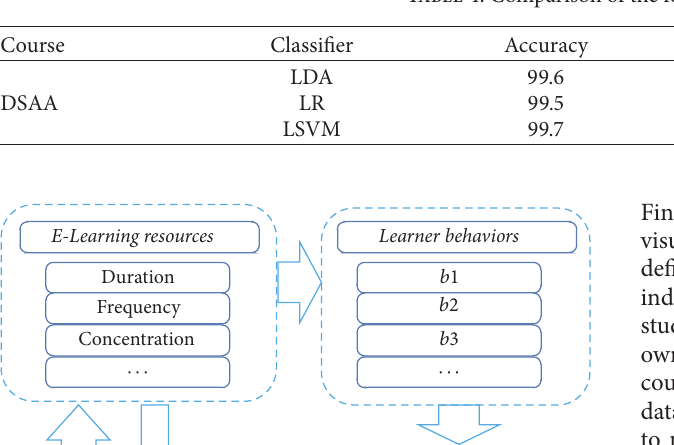
Figure 5: Sequential variation of DSAA course. Table 4: Comparison of the forecasting results.